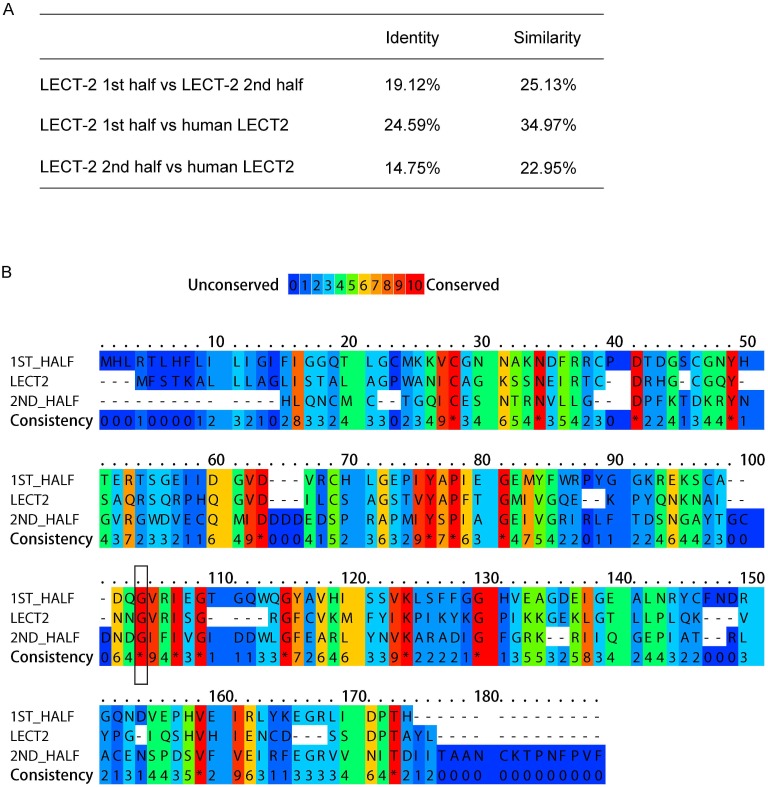
LECT-2 is homologous to human LECT2.(A) Scores of identify and similarity between LECT-2 first half (1–168 amino acids), LECT-2 second half (169–333 amino acids) and human LECT2 (151 amino acids) using SIAS (http://imed.med.ucm.es/Tools/sias.html). (B) Alignment of the amino acid sequences of LECT-2 first half, LECT-2second half and human LECT2 using PRALINE (http://www.ibi.vu.nl/programs/pralinewww/). The conserved glycine residues mutated in wy953 and wy935 mutants were highlighted by a black box.